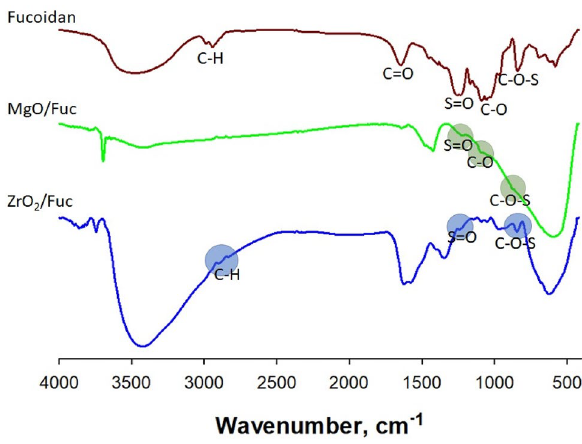
Figure 1. FTIR spectra of fucoidan, MgO/Fuc, and ZrO 2